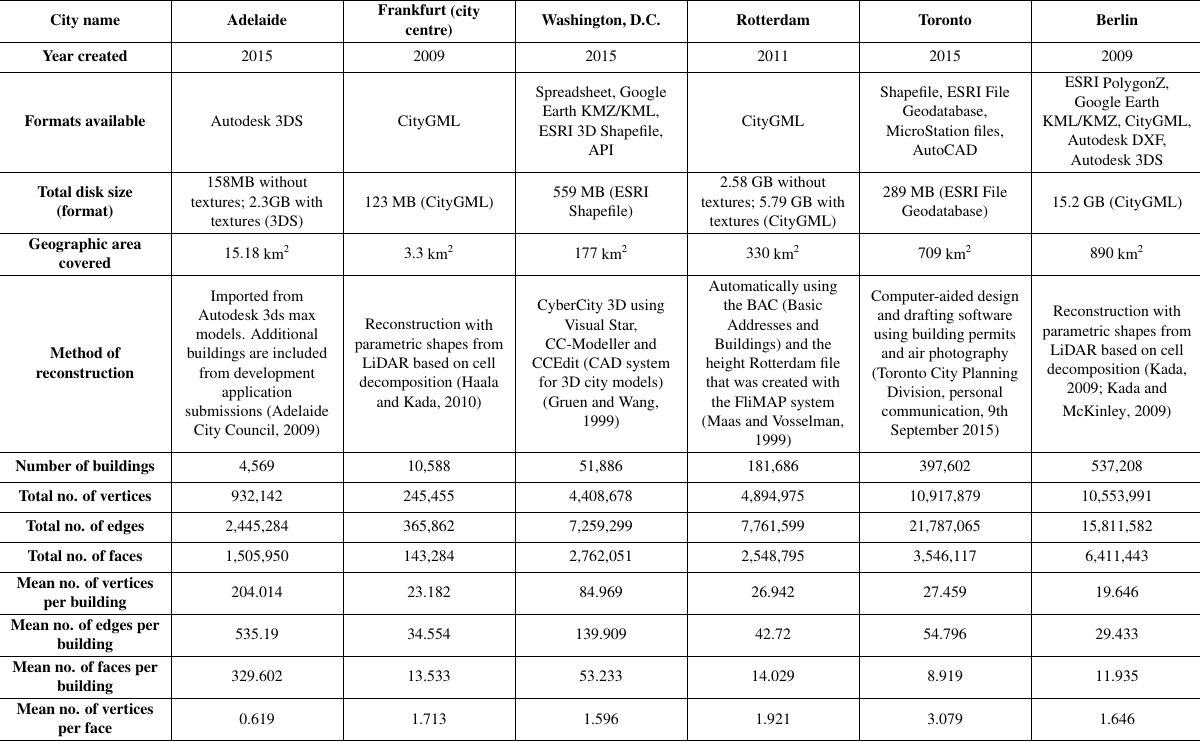
Table 1. Summary of the 3D datasets and metrics